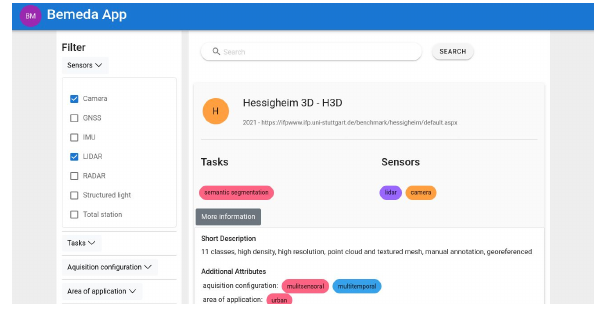
Figure 5. Example of a query with a search filter for all benchmarks with at least a Camera and a Lidar